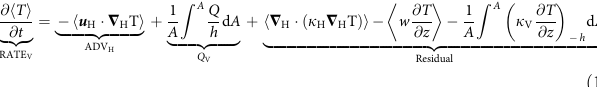
Fig. 6. We calculated the climatology of the temperature budget by averaging T V , T H and T Q across all years (before the 2015/16 event, that is, 2012/13, 2013/14 and 2014/15) and using an 11-day window centred on each day-of-year. The climatology only used data back to 2012, as that is the start of available OceanMAPS data. Temperature budget anomalies for 2015/16 were calculated as the difference between T V , T H and T Q for that year and the